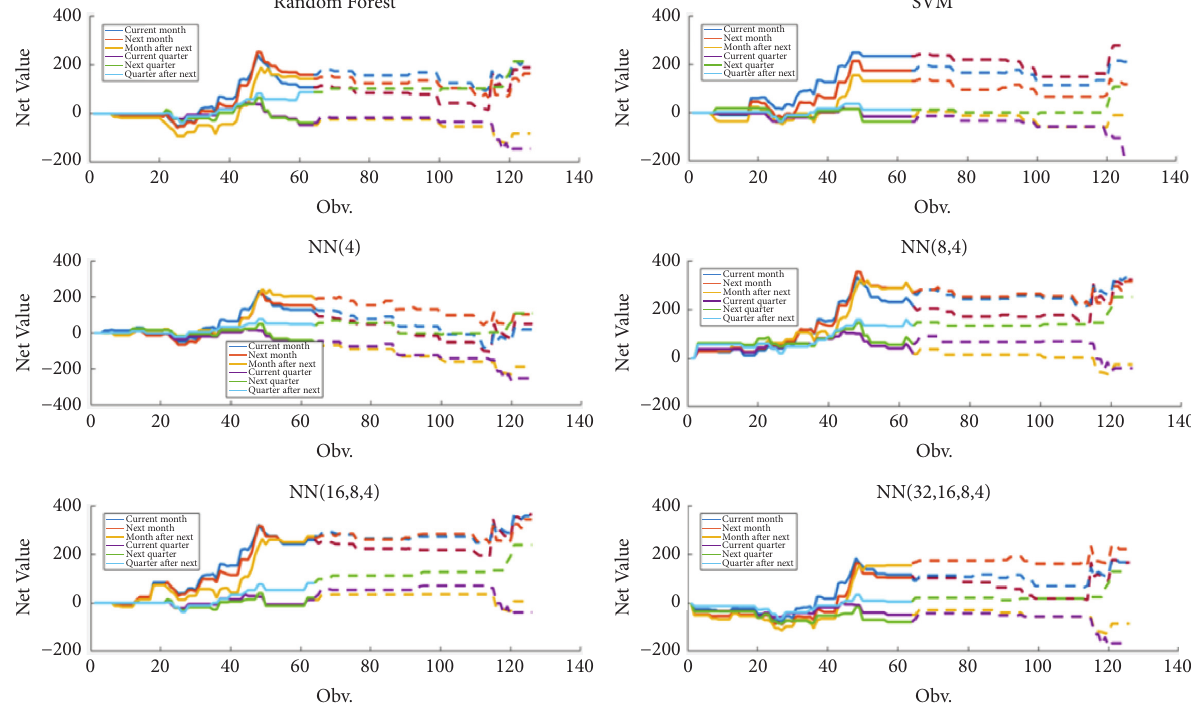
Figure 6: Net value curve of 6 machine learning algorithms on 6 option contracts under [0.05, − 0.2] parameters.